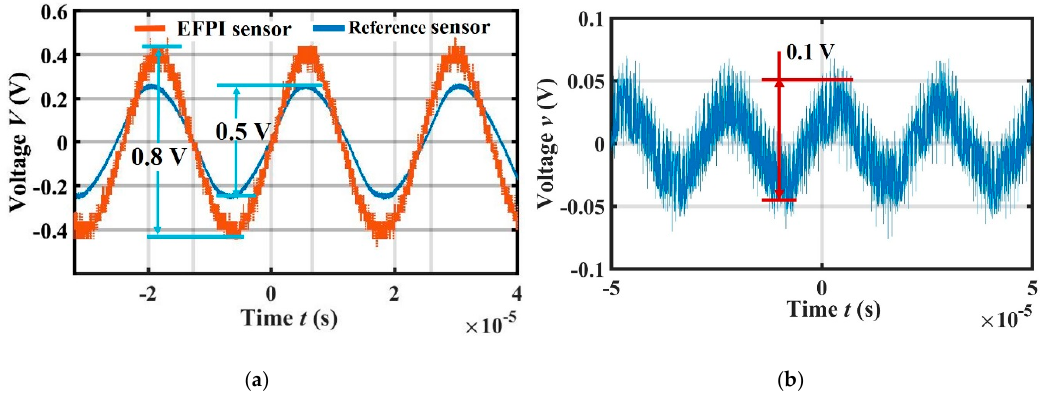
Figure 9. ( a ) Output peak voltages of the EFPI sensor and the reference sensor under the same ultrasonic pressure; ( b ) Minimum output voltage of the EFPI sensor system.